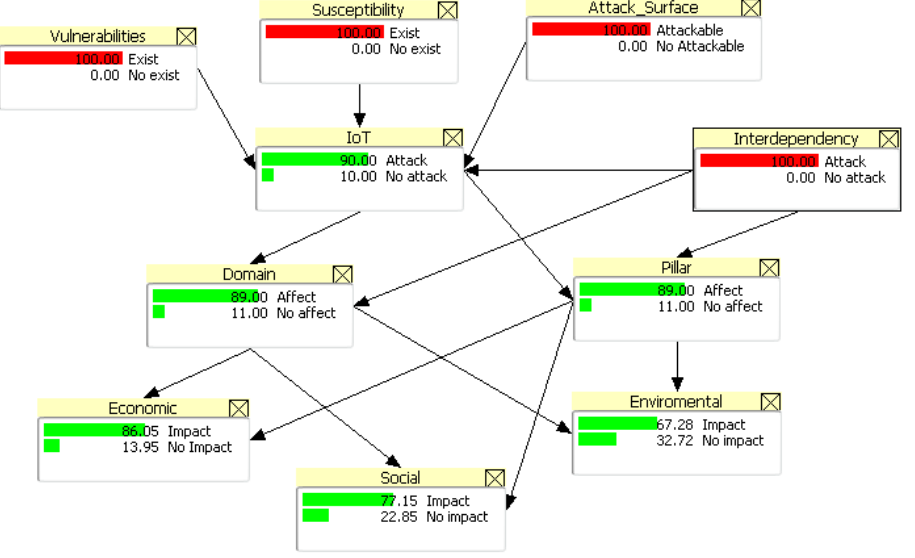
Figure 22. Calculation of the factors of IoT security risk based on the evidence of vulnerabilities, susceptibility, attack surface and interdependency.